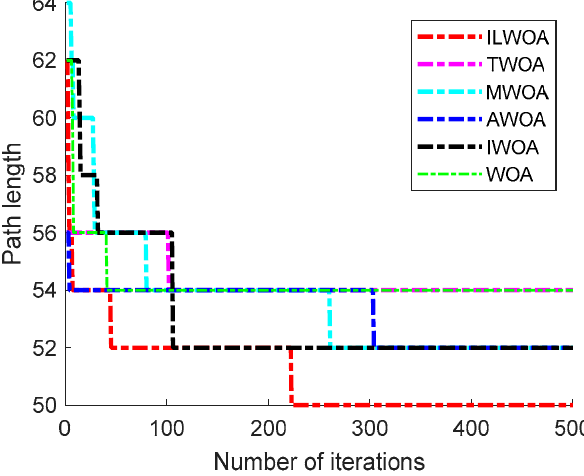
Figure 12. Optimal iteration curve.